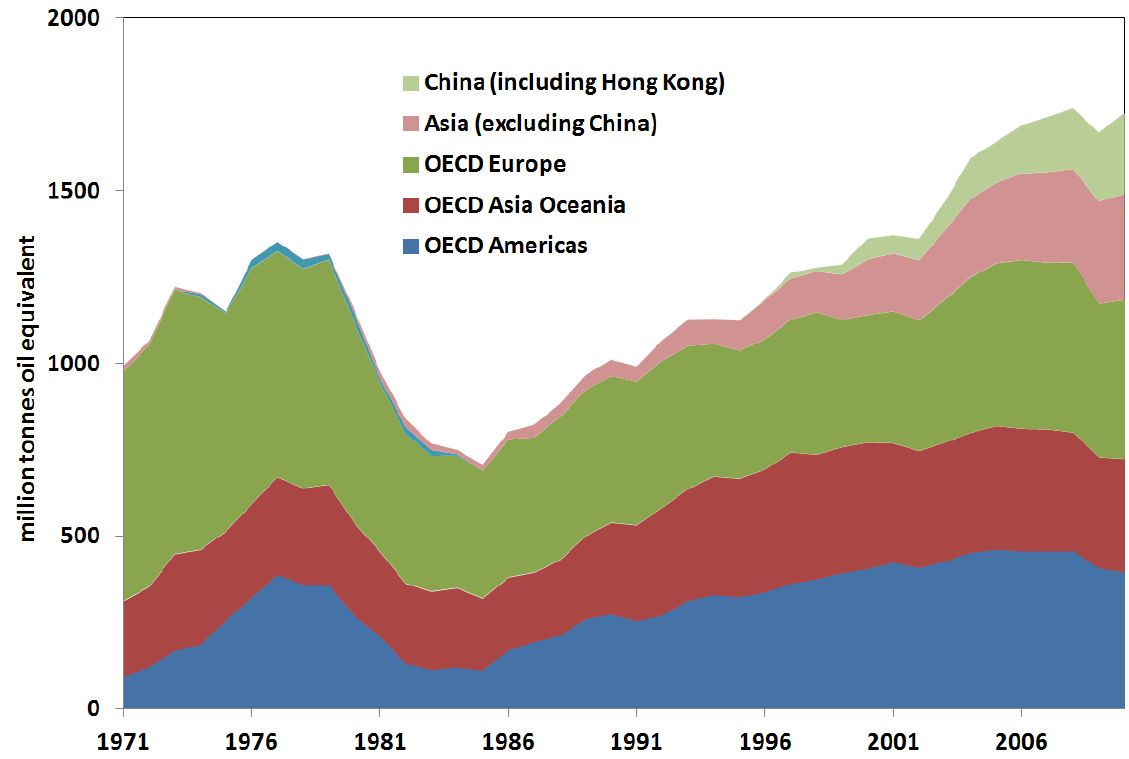
Figure 3. Net crude oil imports 1971–2011